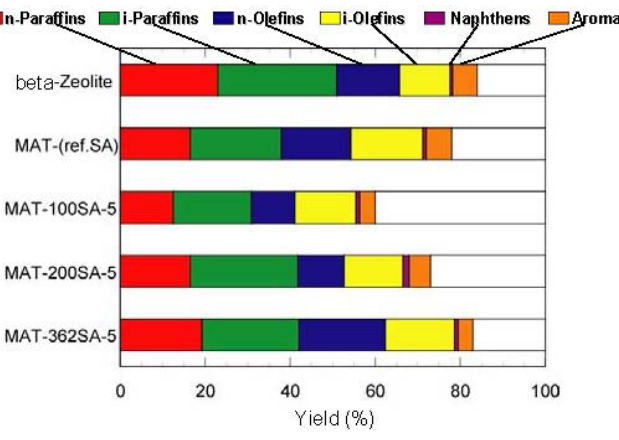
Figure 8. Distribution of carbon numbers on catalytic cracking. Temperature 500 °C,